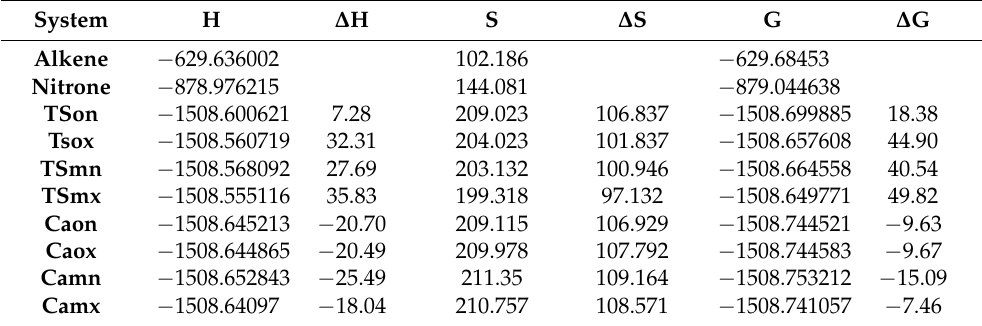
Table 3. Values of total and relative thermodynamic properties for the stationery points associated with the 32CA reaction of nitrone 1 with ethylene 2